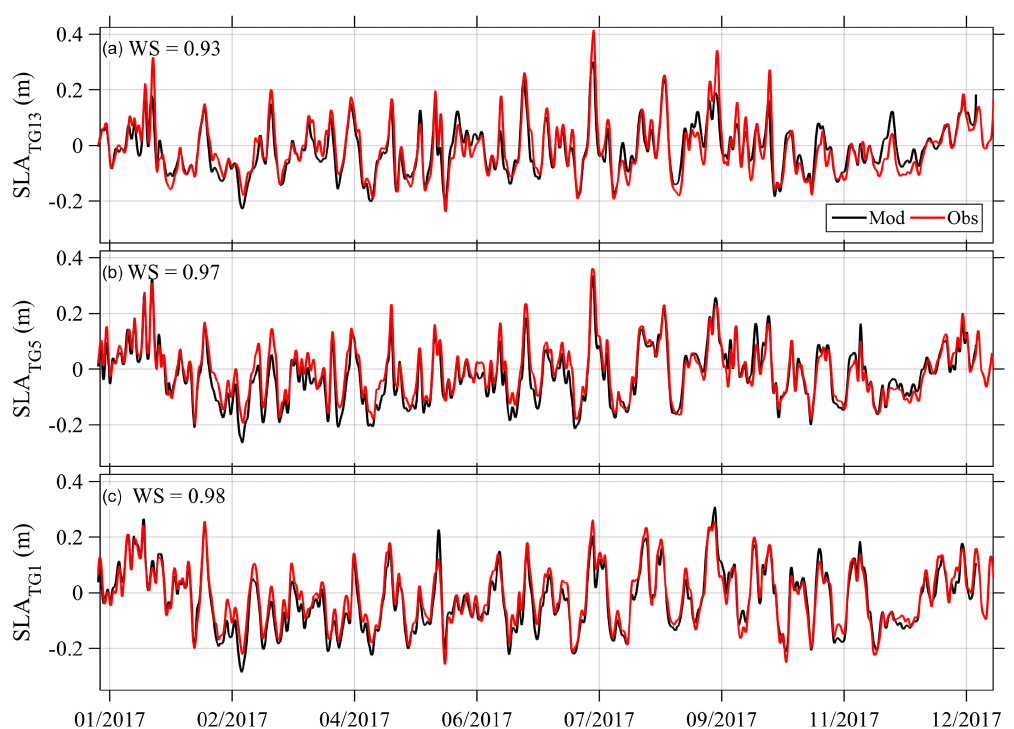
Figure 12. Observed (red) and modelled (black) sub-tidal anomalies of coastal sea level for calendar year 2017 at three stations: Manukau (SLA TG13 , a ), Wellington (SLA TG5 , b ) and Port Chalmers (SLA TG1 , c